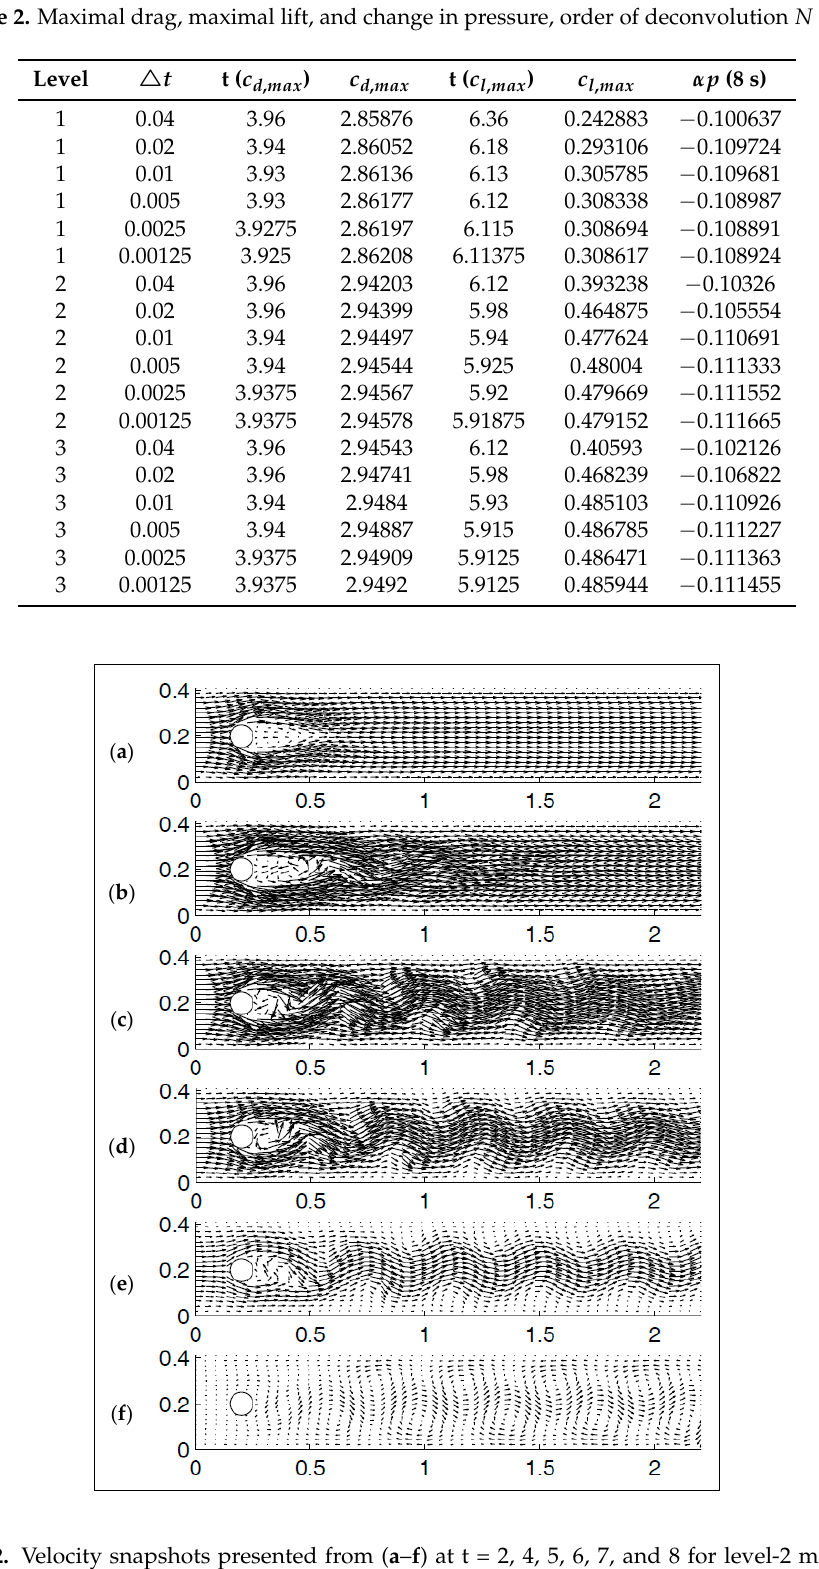
Figure 12. Velocity snapshots presented from ( a – f ) at t = 2, 4, 5, 6, 7, and 8 for level-2 mesh with (cid:52) t = 0.00125, viscosity ν = 10 − 5 , χ = 20, and N =